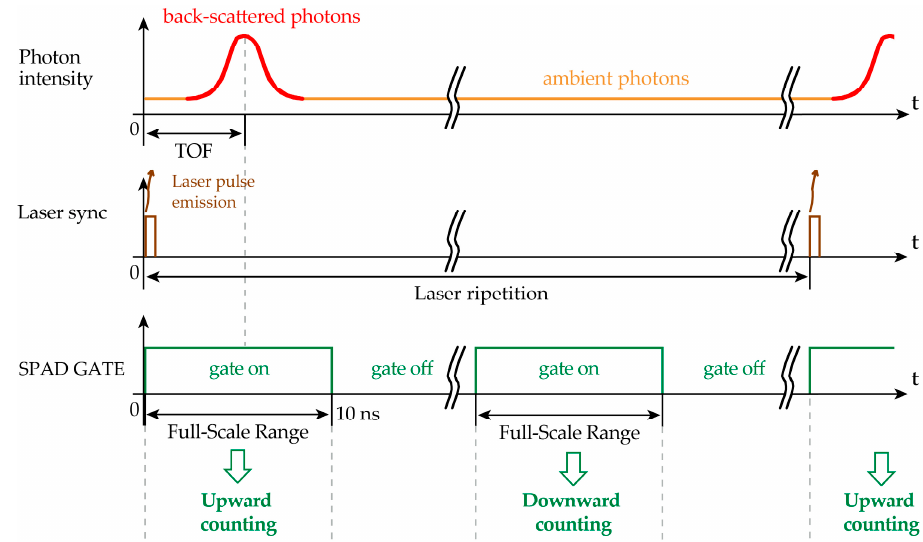
Figure 9. Timing diagram of the signals to properly count ( upwards ) signal and background photons and to subtract ( downwards ) only ambient background photons, during one laser period.